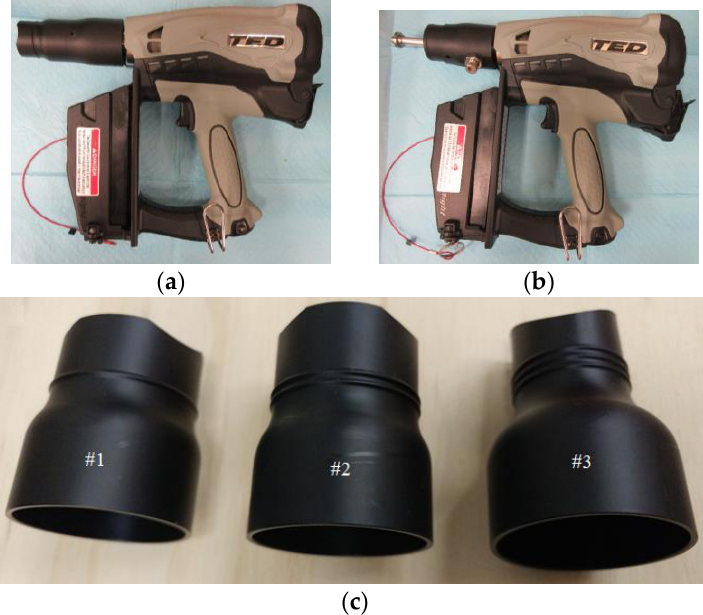
Figure 2. The non-penetrating captive bolt device (Turkey Euthanasia Device). ( a ) Device with adapter 1; ( b ) Device with adapter removed and bolt head exposed; ( c ) Subject adapters [36].